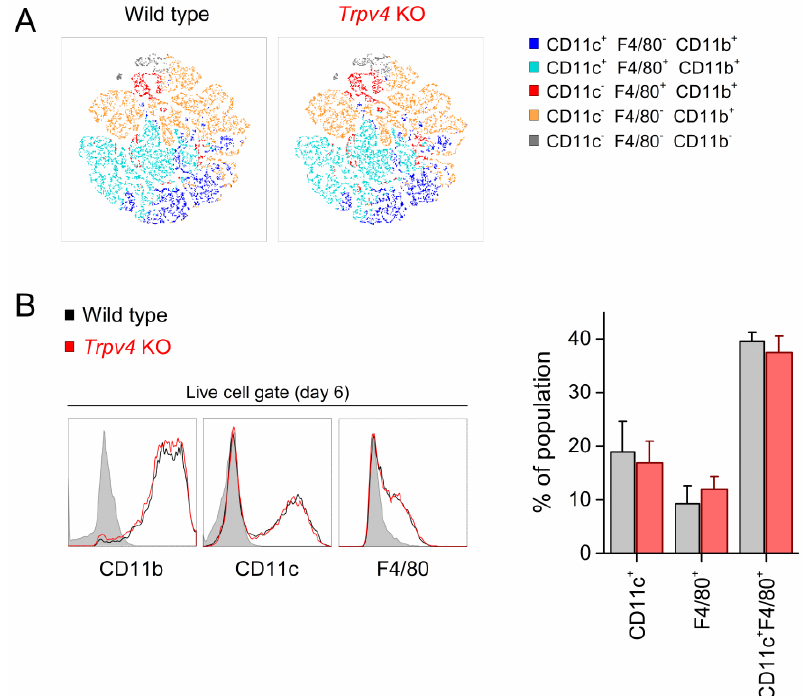
Figure 2. TRPV4wasdispensableinthedifferentiationofCD11c + BMDCs. ( A )Color-codedtwo-dimensional t-distributed stochastic neighbor embedding (tSNE) representations of the total bone marrow-derived cell population (20,000 cells) defined by the surface markers CD11b, CD11c, and F4 / 80. ( B ) Histograms showing surface expression of the indicated markers in bone marrow-derived cells from wild-type (WT, black traces) and Trpv4 knockout (KO, red traces) mice. The shaded histograms represent specificity (fluorescence minus one) controls. The bar graph shows the percentage of different cell populations present in total bone marrow-derived cell cultures defined by the surface expression of CD11b, CD11c, and F4 / 80. The data are represented as mean ± SEM of nine independent